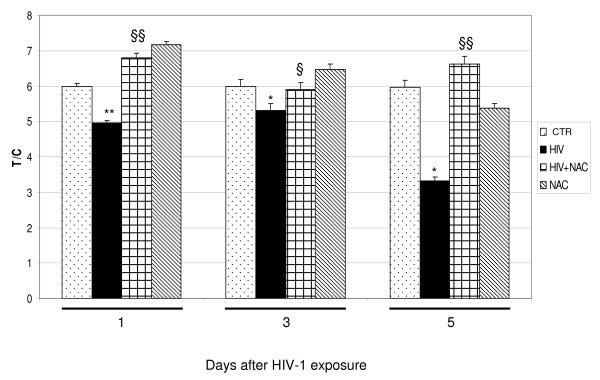
Telomere length in U373 at different time points (1, 3, 5 days) following HIV-1 exposure or NAC treatment. Each data is shown as percentage of T/C (telomere/centromere) ratio. A statistically significant telomere shortening was observed for U373 after HIV-1 exposition at all time points while NAC treatment was able to inhibit this effect. *P < 0.05 and **P < 0.001 when compared vs control; §P < 0.05 and §§ P < 0.001 when compared vs HIV-1. F: 96.59, 9.01, 8229, respectively at day 1, 3, 5.